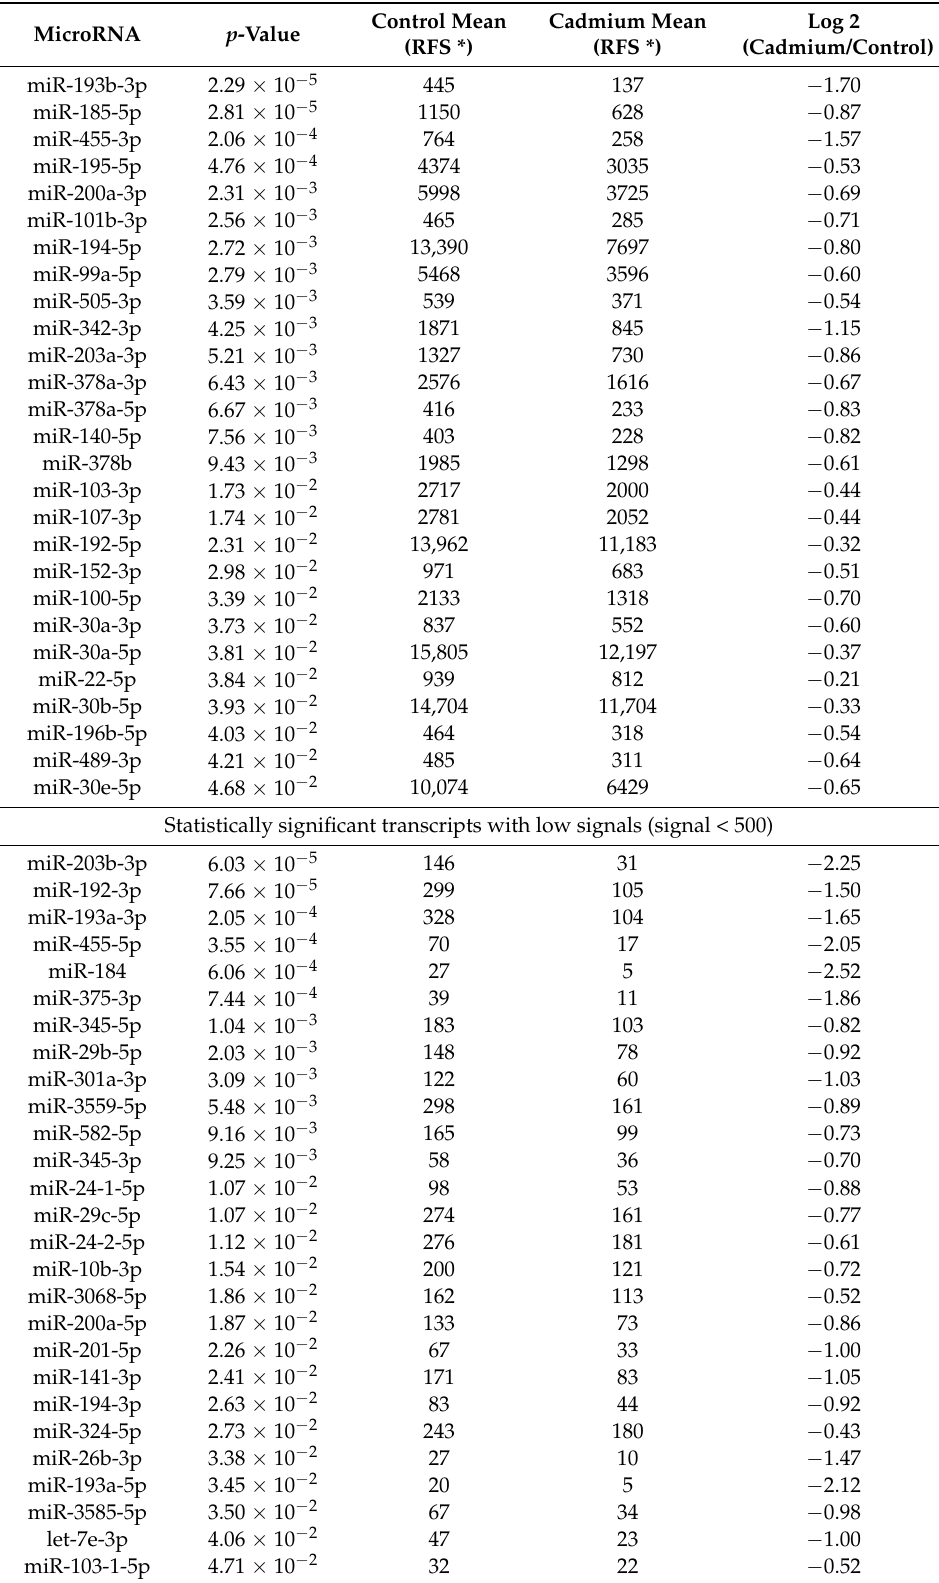
Table 2. MicroRNAs with significantly decreased expression in the renal cortex of Cd-treated rats as determined by µ Paraflo™ microRNA microarray